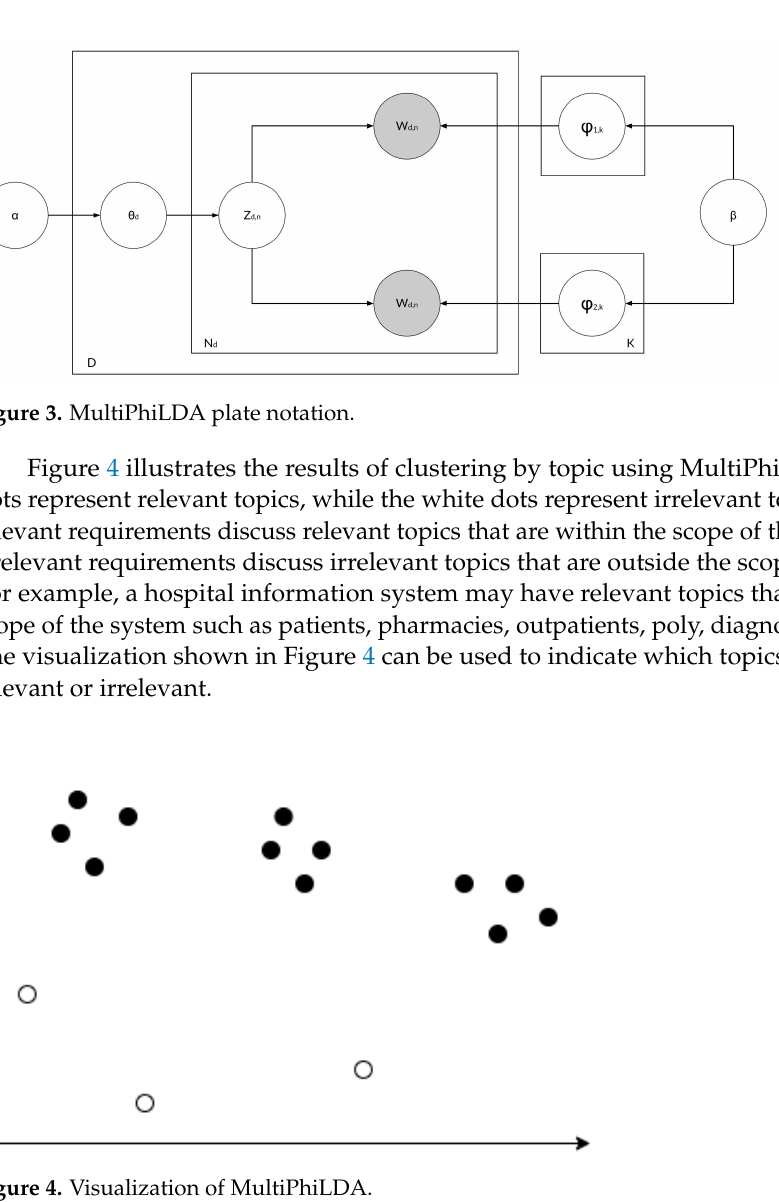
Figure 4. Visualization of